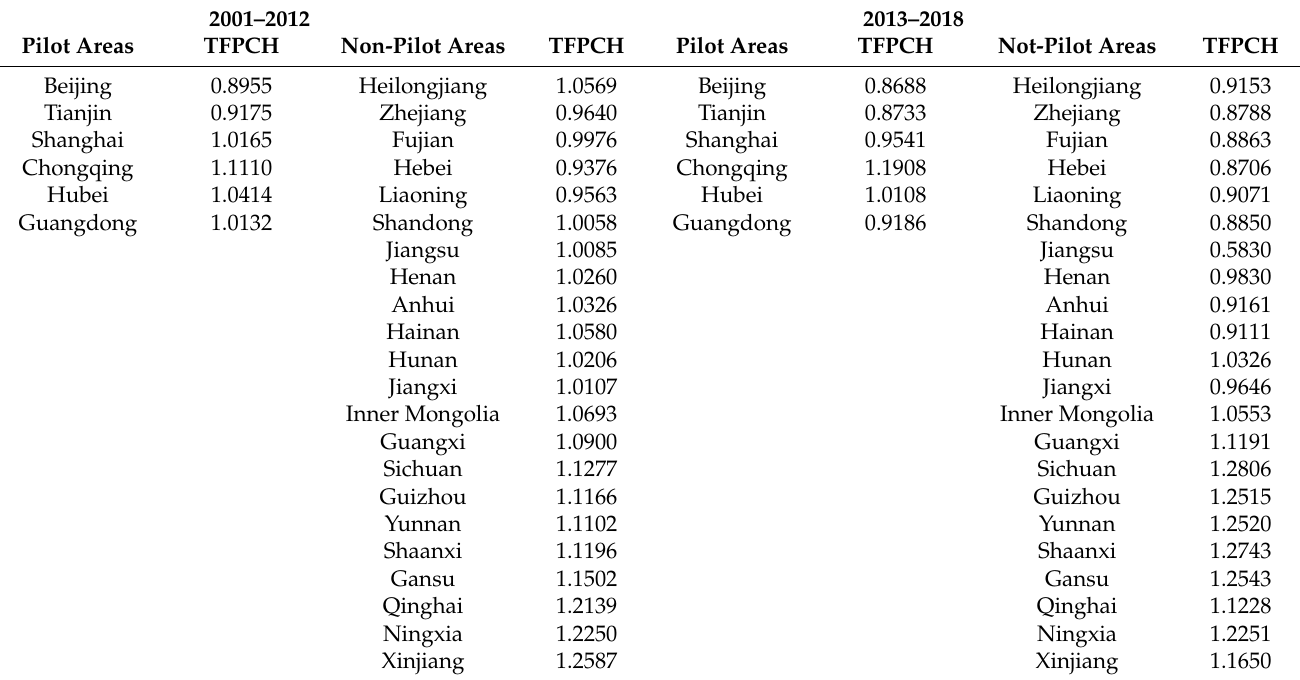
Table 2. Average green total factor productivity from 2001 to 2012 and from 2013 to